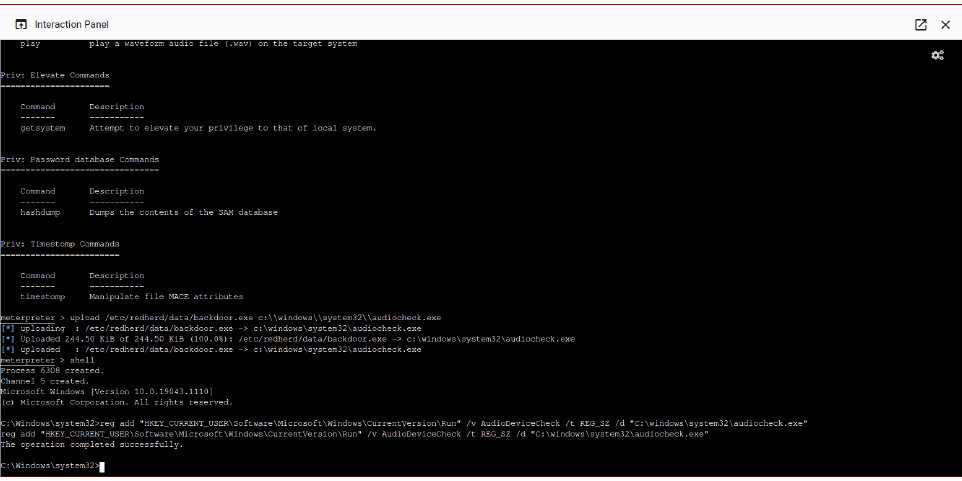
Figure 11. Malware persistence installation on the